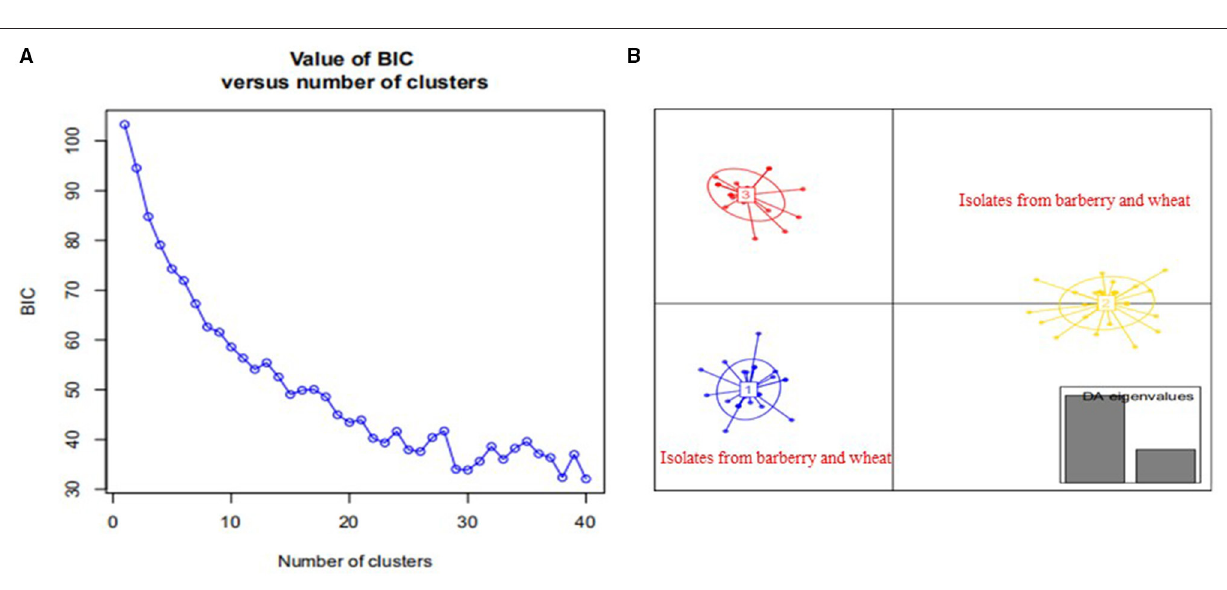
FIGURE 8 | Discriminant analysis of principal components (DAPC) analysis of Puccinia striiformis f. sp. tritici populations sampled from barberry bushes and nearby wheat plants. (A) Value of Bayesian information criteria vs. the number of clusters for all P. striiformis f. sp. tritici isolates. (B) Scatter-plot of the P. striiformis f. sp. tritici isolates from barberry and wheat plants, and eigenvalues of the analysis are displayed in gray bars in the right